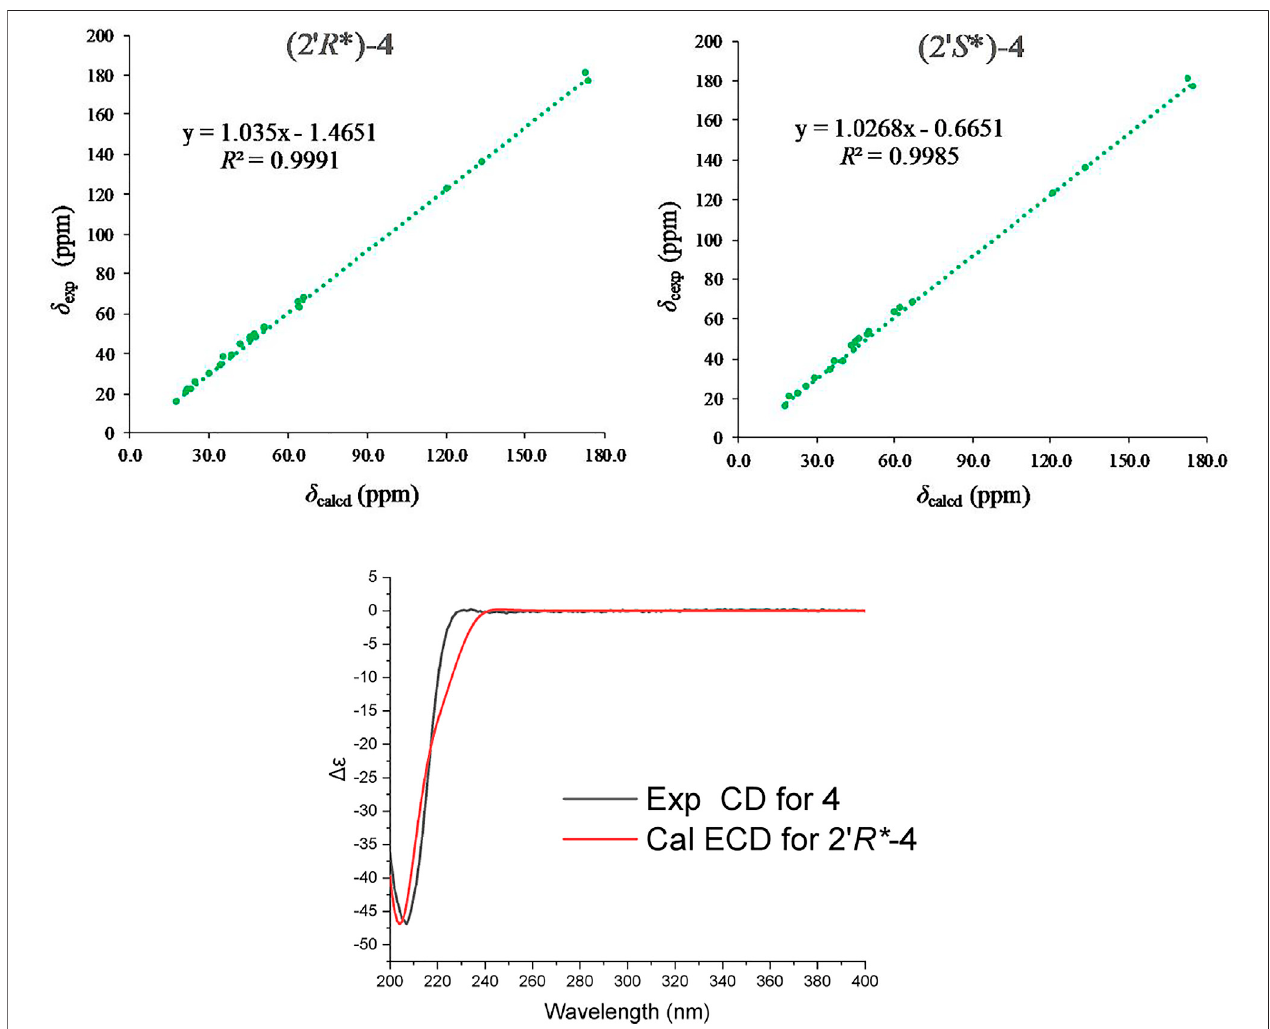
FIGURE 7 | Regression analysis of the NMR calculations of the two possible con fi gurations, (2 ′ R *) and (2 ′ S *)- 4 , and ECD calculation result of 4 .